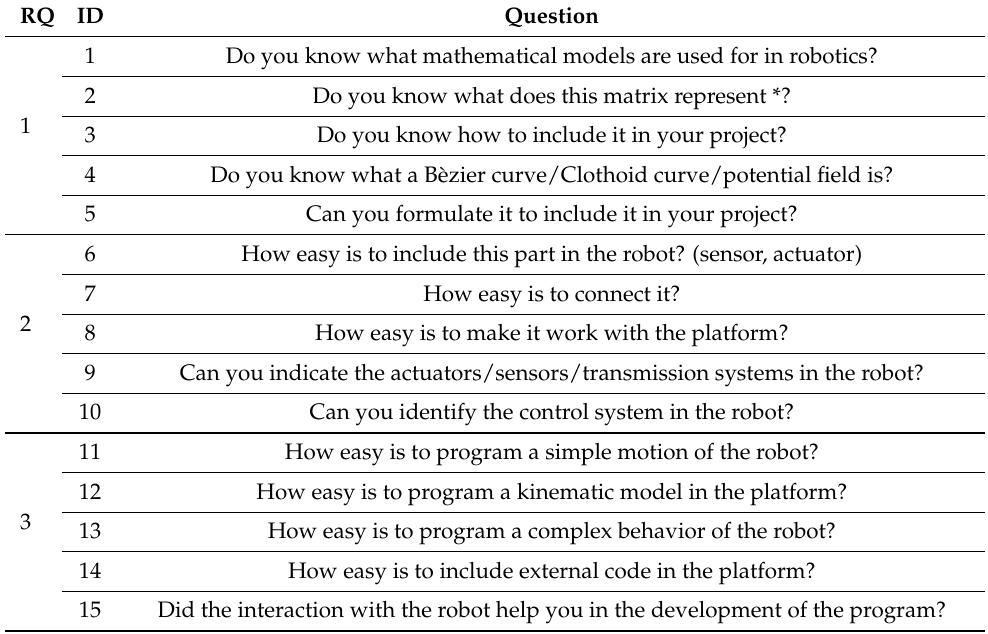
Table 1. Questions in the mini-interviews associated with the research questions (RQs).